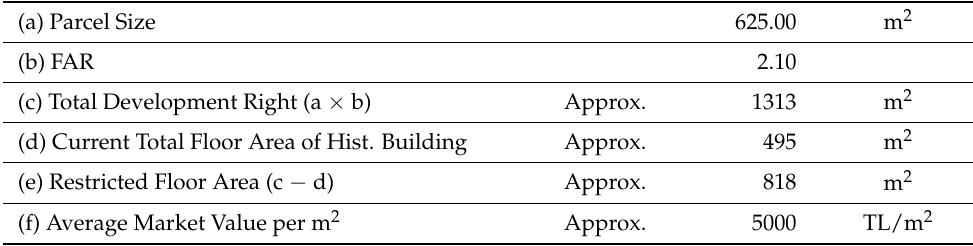
Table 1. Overview of the calculations of Example